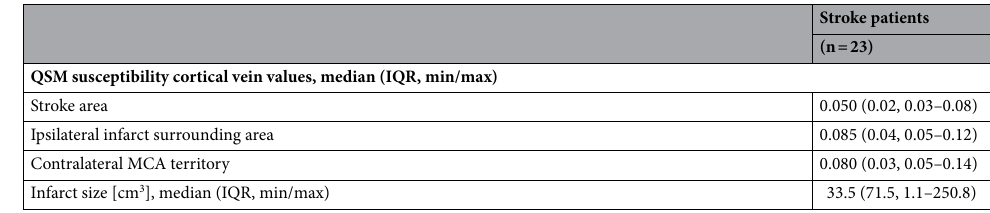
Table 3. QSM susceptibility and infarct size. QSM susceptibility values of cortical veins within the stroke area, the ipsilateral infarct surrounding MCA territory and the contralateral MCA territory. Additionally, we calculated the median infarct size on DWI. Median, interquartile range ( IQR ), minimum and maximum are shown.